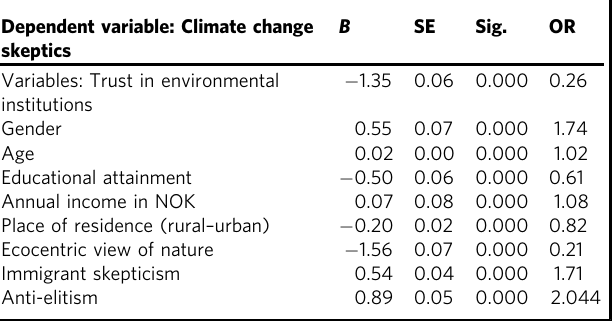
Table 2 Bivariate logistic regressions (OLS).